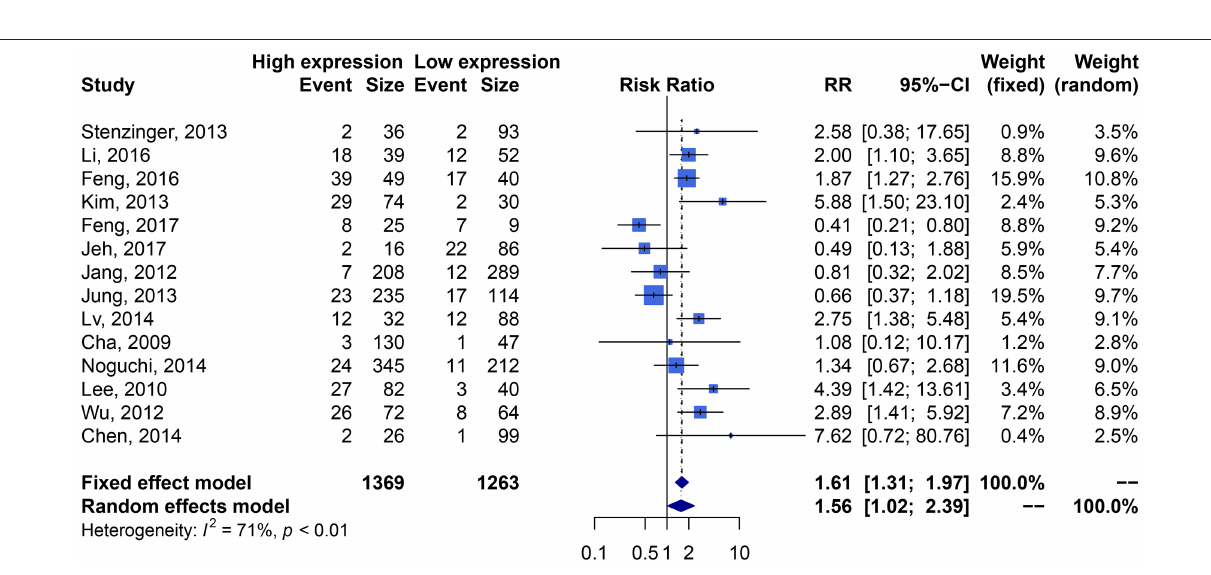
Frontiers in Endocrinology |